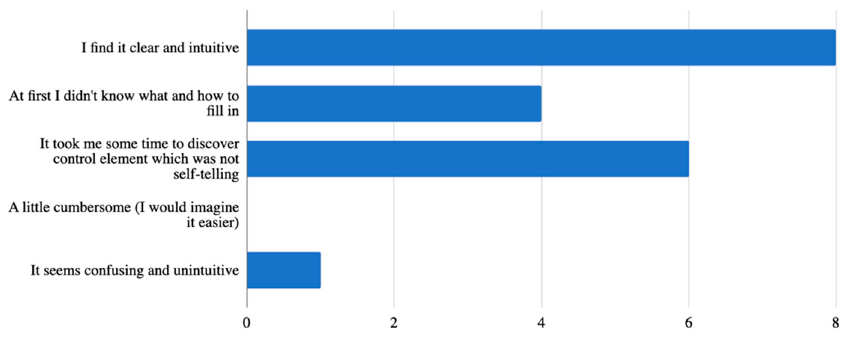
Figure 3. Control of the mobile application.